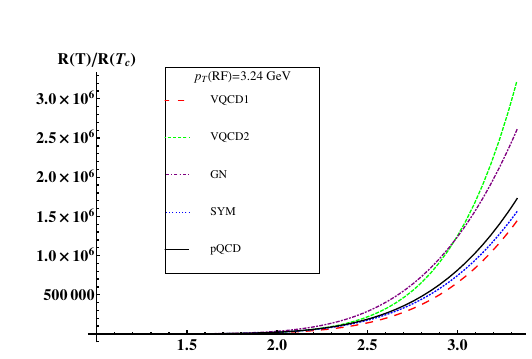
Figure 9 . Ratios of emission rates versus tem- perature at high p T = 3 : 24 GeV in the rest